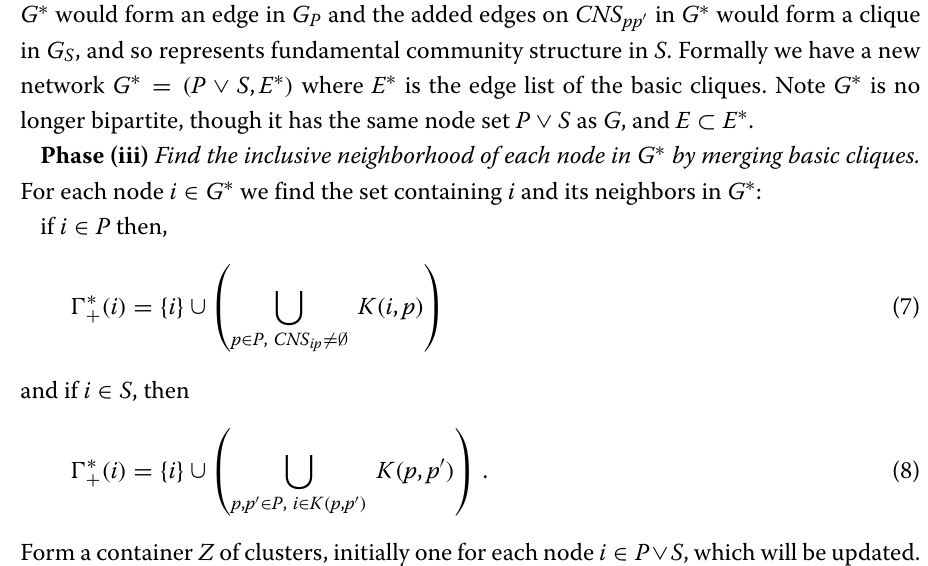
Phase (ii) Replace each basic biclique by a clique. Connect each node in K ( p , p (cid:11) ) = { p , p (cid:11) , (cid:3)( p ) ∩ (cid:3)( p (cid:11) ) } to every other node in it, to form the basic clique K ∗ ( p , p (cid:11) ) . Each